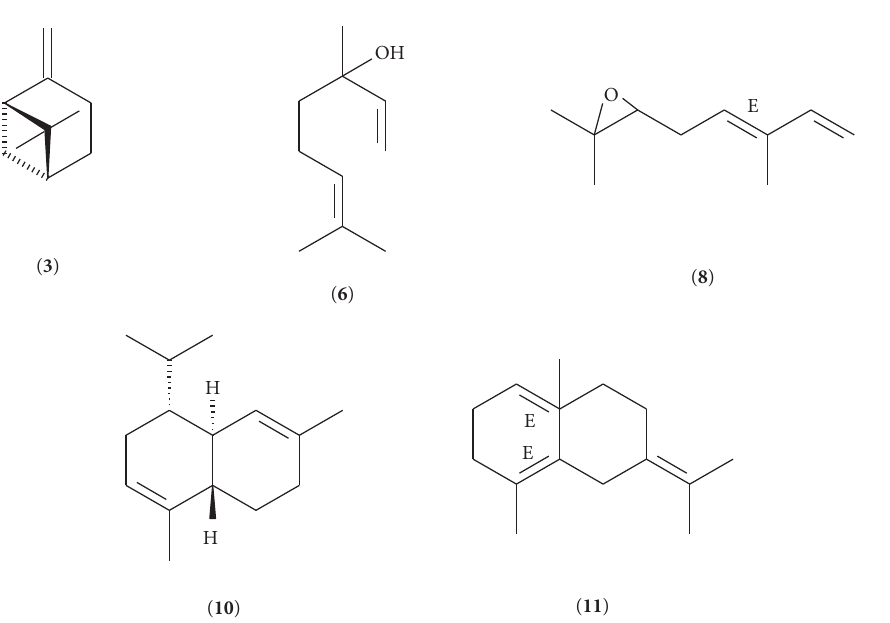
Figure 1: Chemical structure of major compounds identified in the essential